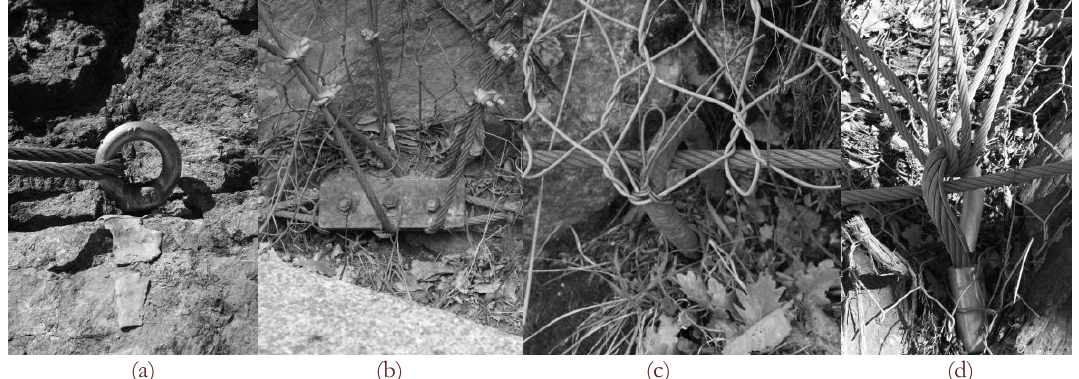
Figure 3: Different anchors types and connection with the ropes and the mesh: (a) a grouted bar with a screwed steel hoop, (b) an injected cable, (c) a grouted bar with a plate, (d) an anchorage